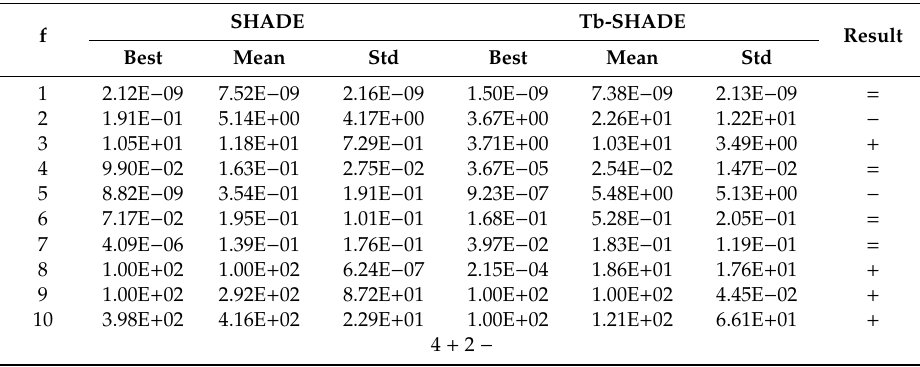
Table 8. SHADE vs. Tb-SHADE on CEC2020 in 10 D